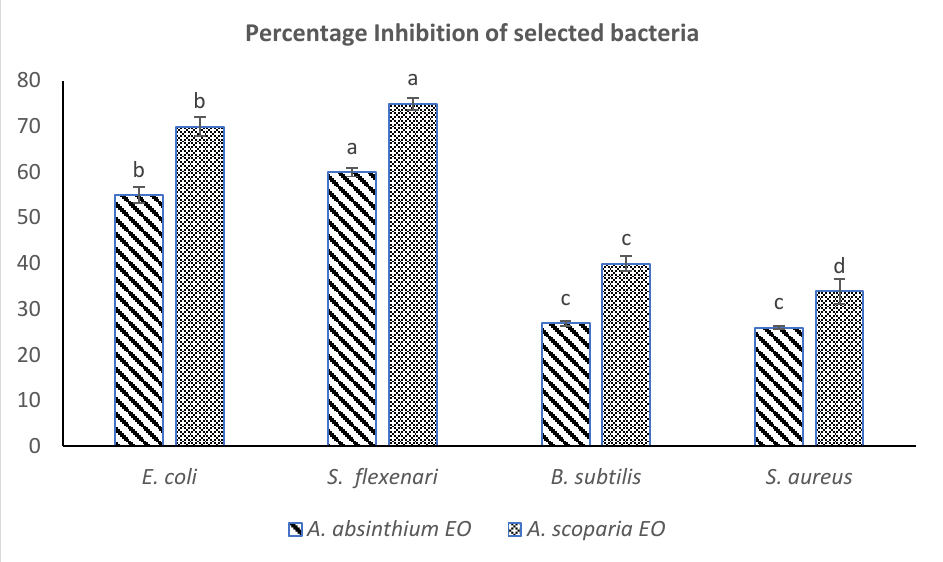
Figure 2. Comparative antibacterial effect (% inhibition) of EOAS and EOAA (dose of 500 µg/mL DMSO). One same letter shows no significant difference.